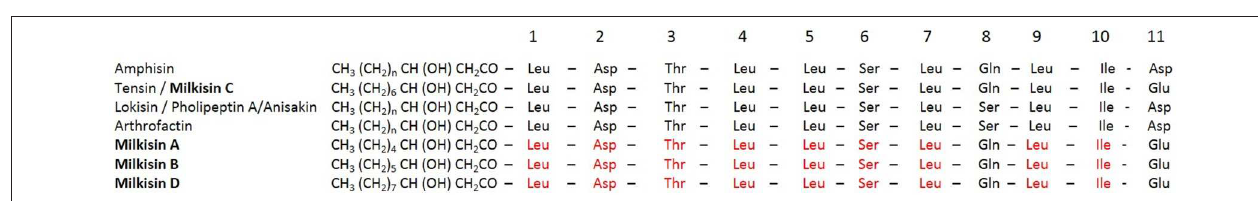
Frontiers in Microbiology | www.frontiersin.org